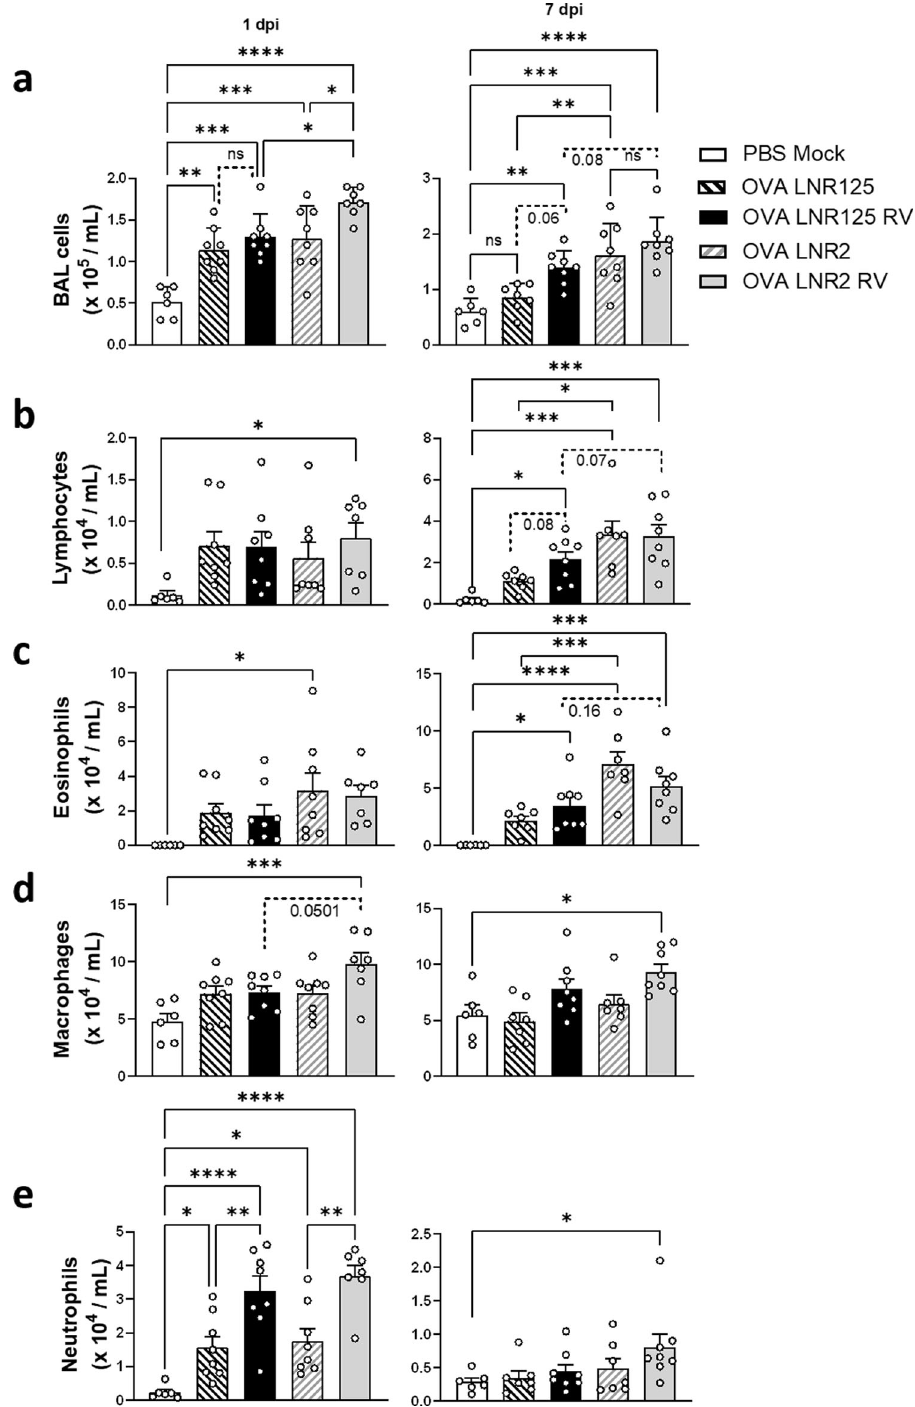
Fig. 7 IL-25 blockade reduced immune cell in fi ltration at peak- and resolution of in fl ammation in allergic mice and mice with RV-induced exacerbation. Mice were sensitised and challenged to ovalbumin (OVA). On the same day as second challenge dose, mice were treated with LNR125 or LNR2, intraperitoneally followed by infection with RV-A1, 6h post fi nal challenge. Bronchoalveolar lavage (BAL) was performed to innumerate immune cell counts at day 1- and 7- postinfection. ( a ) Total BAL counts, ( b ) lymphocyte, ( c ) eosinophil, ( d ) macrophage and ( e ) neutrophil cell counts. Bars represent mean + SEM, n = 6 – 8 mice. * P <0.05, ** P <0.01, *** P <0.001, **** P <0.0001 by mixed effects model of 2-way ANOVA with Holm-Sidak ’ s correction for multiple analyses. P values > 0.05 denoted by exact P values and broken